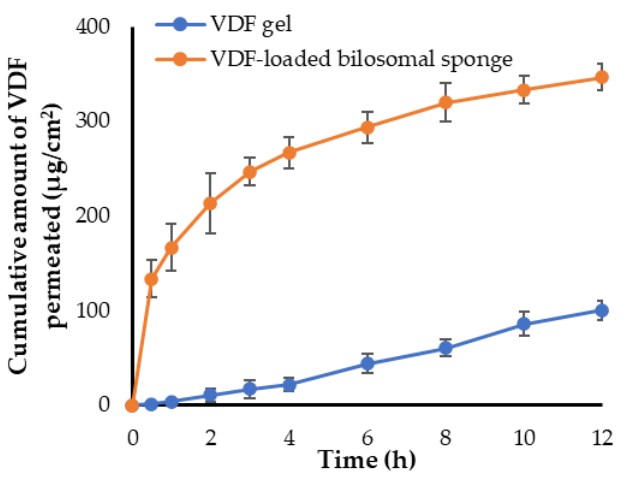
Figure 7. Ex vivo permeation of VDF-loaded bilosomal sponge from sheep buccal mucosa. Table 3. Ex vivo permeation of VDF gel and VDF-loaded bilosomal formulation from sheep buccal mucosa.